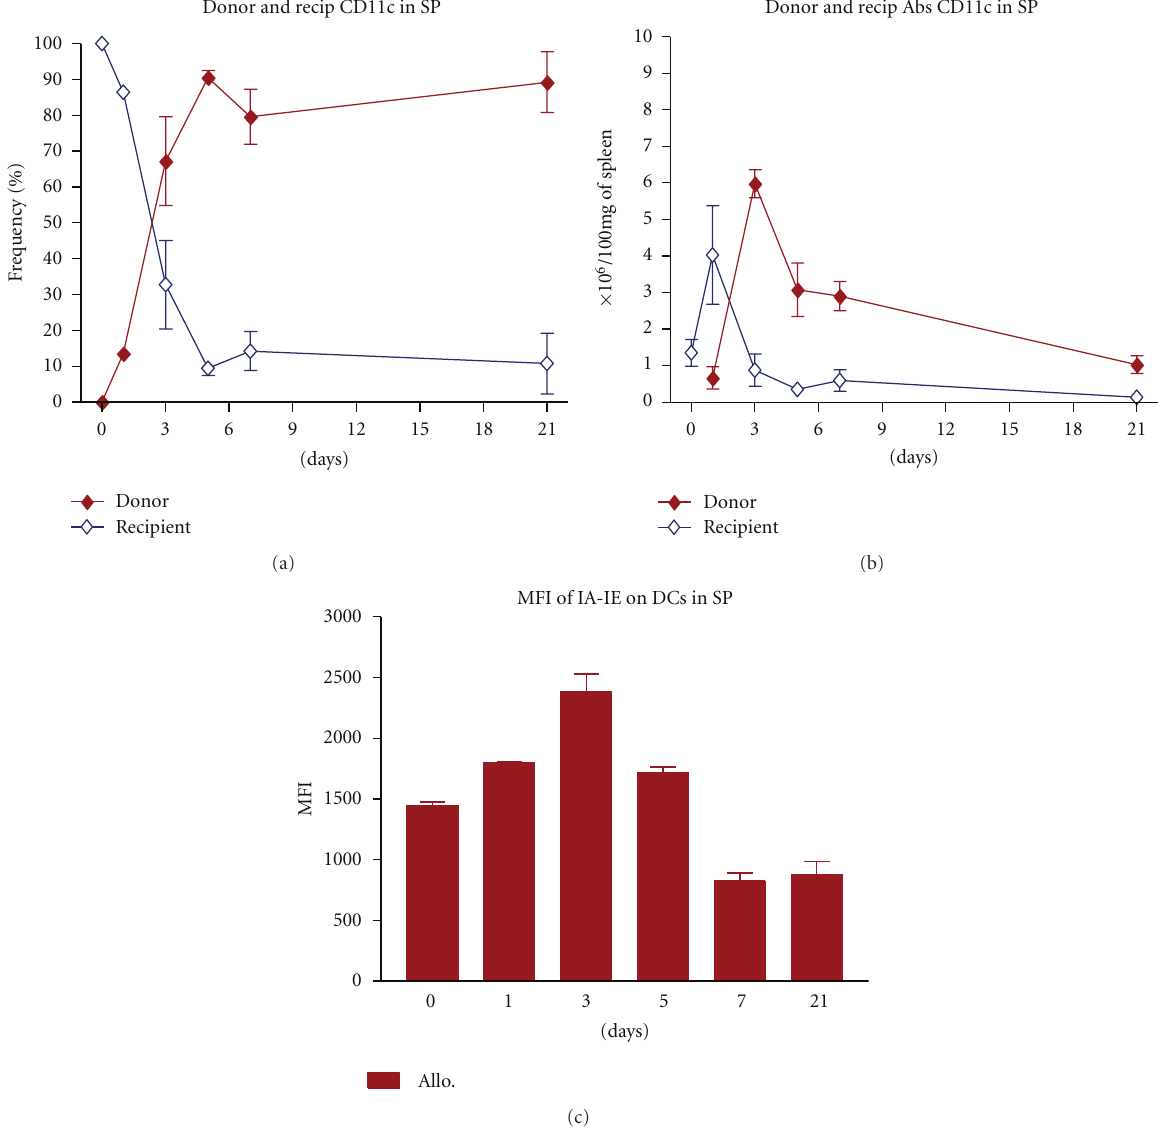
Figure 3: Dendritic cells chimerism and activation pattern in GVHD developing mice. Spleens of allogeneic transplanted recipients were evaluated for dendritic cell chimerism and maturation marker. (a, b) Frequency and expansion pattern of donor (CD11c+ and H-2Kb) versus host (CD11c+ and H-2Kd) dendritic cells in the spleen of recipient mice in GVHD developing setting. (c) Maturation status of DCs was evaluated using expression level of MHC class II on DCs surface. Three days after BMT donor DCs has higher expansion with more expression of maturation marker on cell surface. ( (cid:2) ): donor DCs (CD11c+ and H-2Kb), ( ♦ ): host DCs (CD11c+ and H-2Kd). All values are mean ± SE for 4 to 6 animals in each group per time point. Di ff erences were analyzed statistically employing U-test, compared between groups ( ∗ P < .